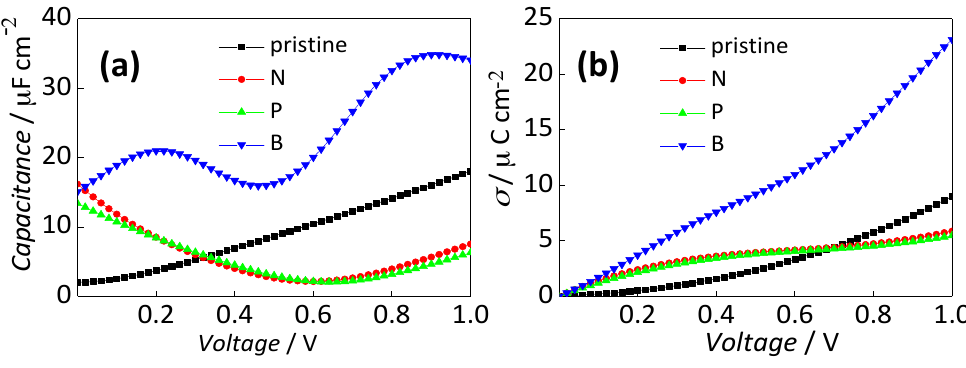
Figure 4. Energy storage performance of doped graphene. ( a ) quantum capacitance (QC) and ( b ) excessive surface charge density (ESCD).